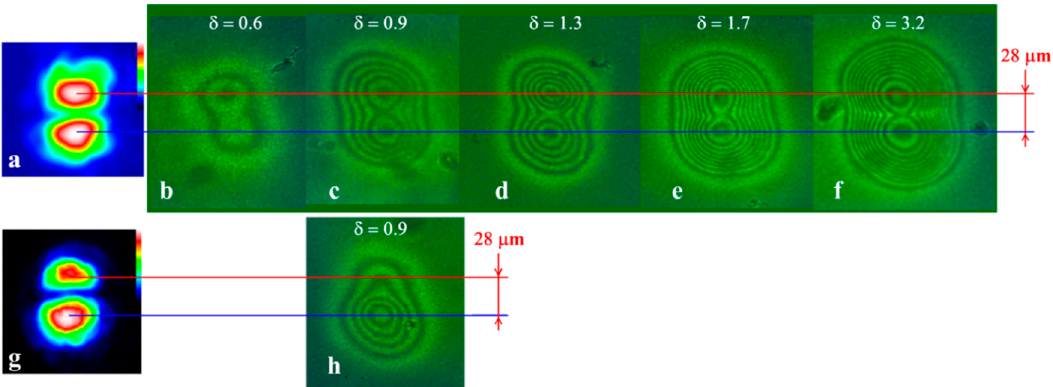
Figure 7. Microphotographs in the case of ( a ) symmetrical and ( g ) asymmetrical beam intensity for normalized beam power: δ = ( b ) 0.6, ( c ) 0.9, ( d , h ) 1.3, ( e ) 1.7, and ( f ) 3.2. Oblique incidence (a = 35°). The distance between the intensity peaks is 𝑑 = 28 μ m.